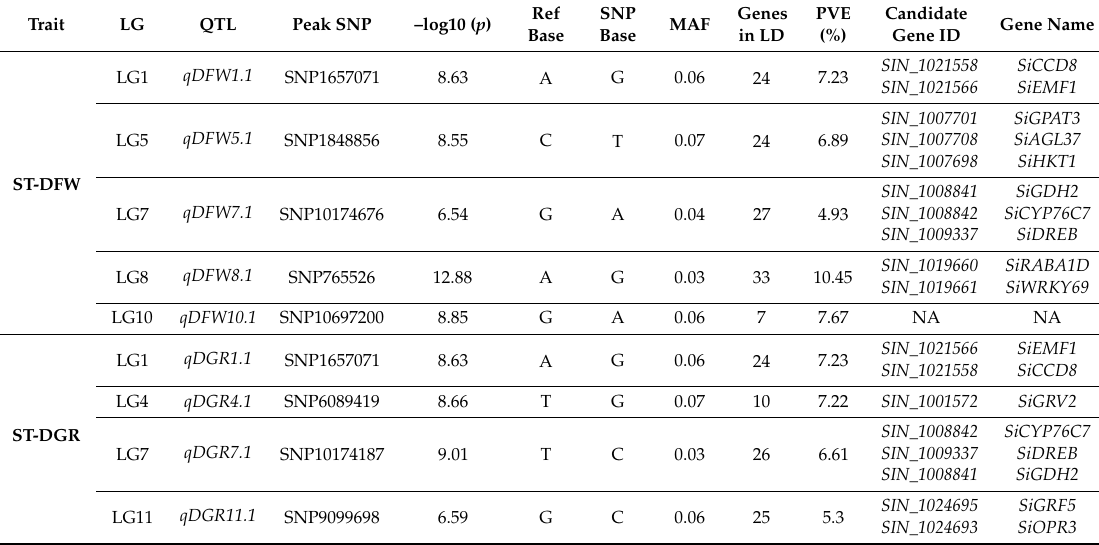
Table 3. SNPs significantly associated with PEG-induced drought tolerance indexes at the germination stage in sesame.